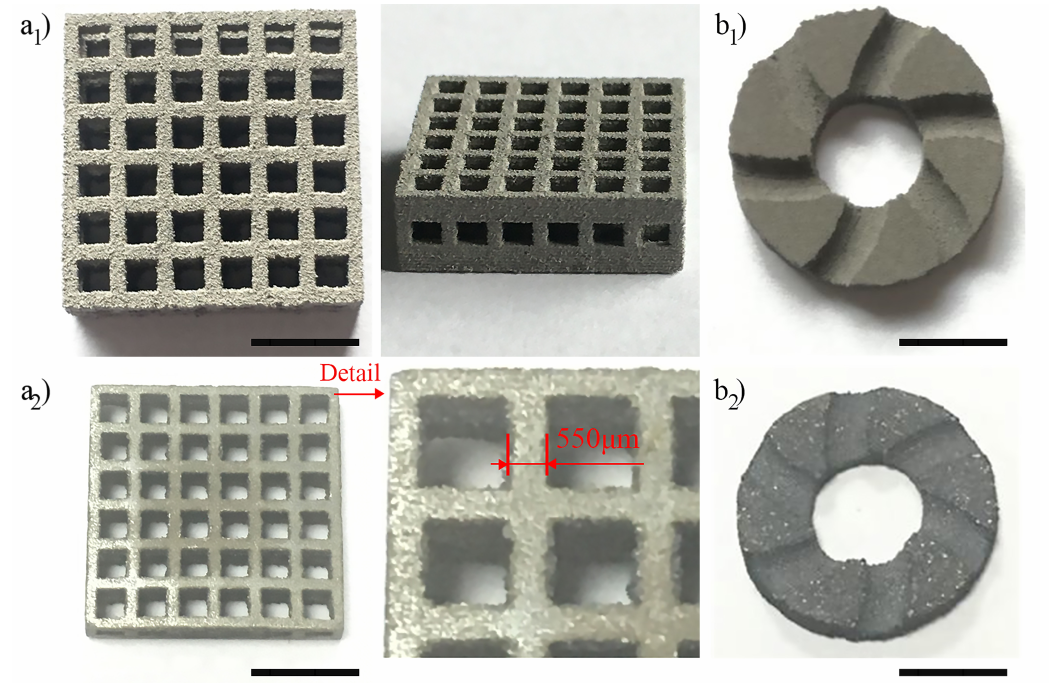
Figure 16. The optical images of Ti6Al4V parts with lightweight porous ( a1,a2 ) and curved structure ( b1,a2 ): before sintering ( a1 , b1 ) and after sintering ( a2 , b2 ). Scale bar = 0.5